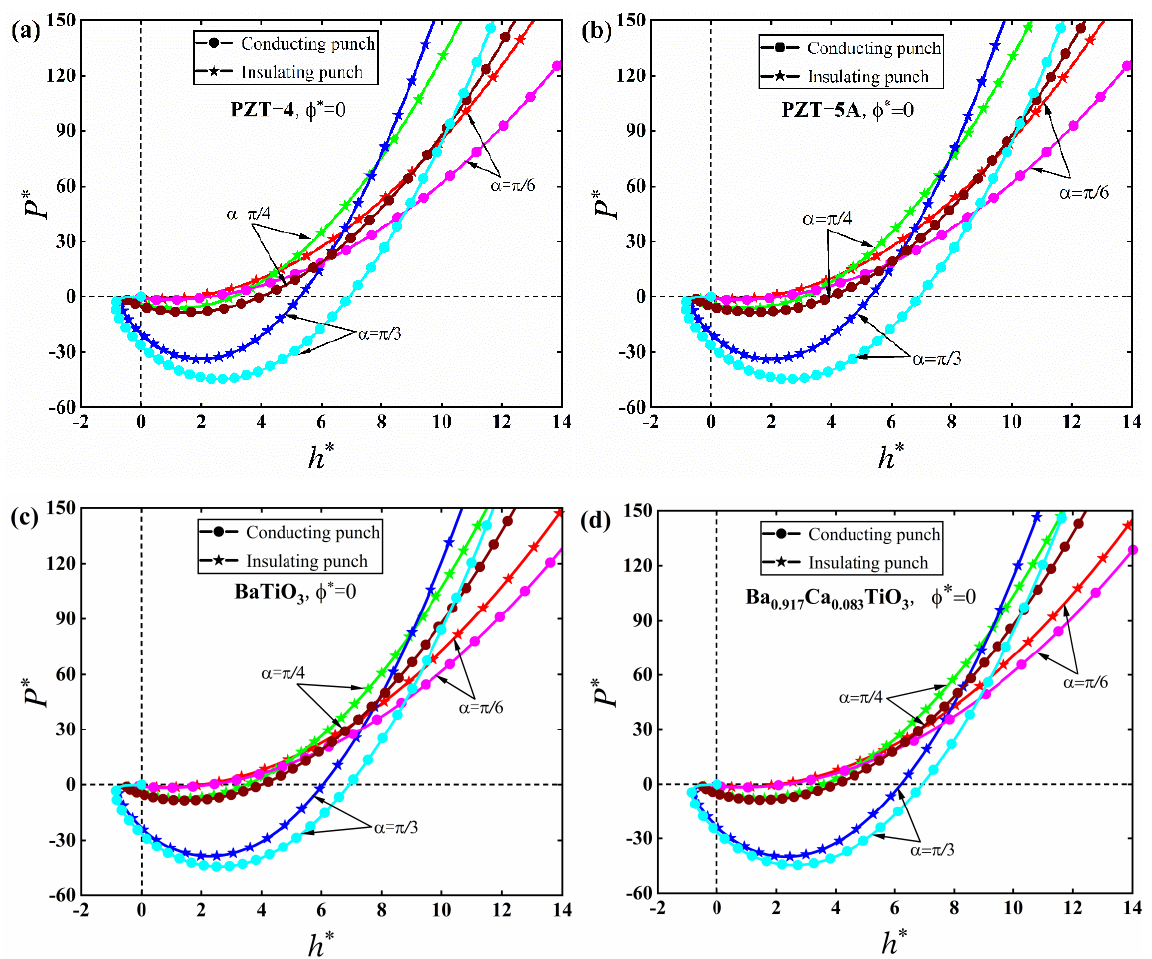
Figure 7. Variation of the dimensionless indentation force, P ∗ , with the dimensionless indentation depth h ∗ at the different values of α = π /6, π /4 and π /3 for the conducting punch with zero electric potential and the insulating punch. ( a ) PZT-4. ( b ) PZT-5A. ( c ) BaTiO 3 . ( d ) Ba 0.917 Ca 0.083 TiO 3 .